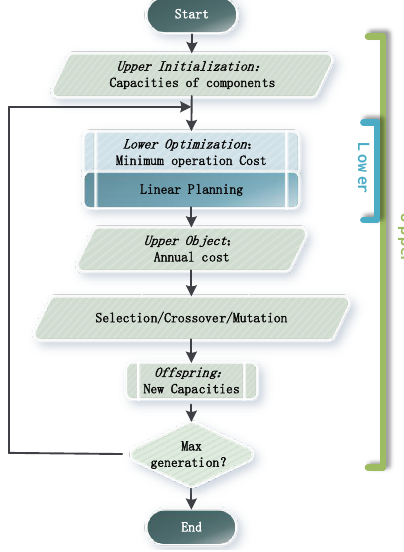
Figure 3. Flowchart of solution algorithm.